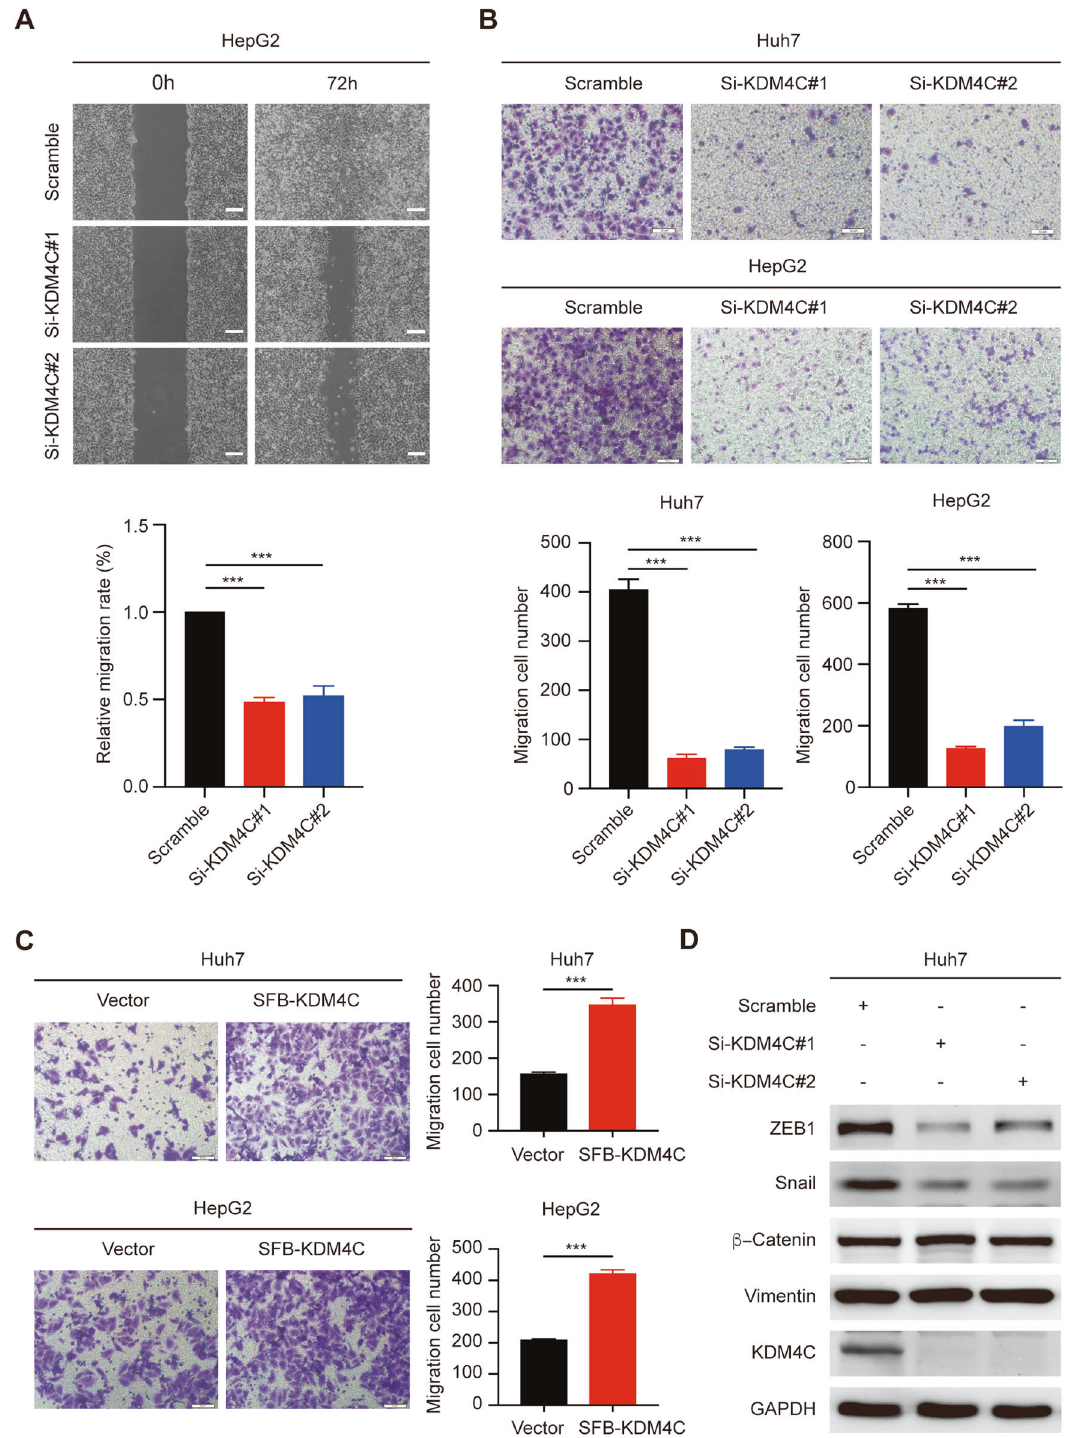
Fig. 3 Inhibition of KDM4C suppresses HCC cell migration. A Upper panel: the con fl uent monolayer of HepG2 cells in each group was scratched and cultured for an additional 72 h to measure the wound-healing rate. Lower panel: the relative area migration rate was calculated ( n = 3). B , C Transwell assays were performed to evaluate the migration of Huh7 and HepG2 cells. Quanti fi cation of the migrated cell number is shown in histograms ( n = 3). D Huh7 cells were transfected with KDM4C siRNAs for 48 h and then collected and analyzed by western blotting ( n =